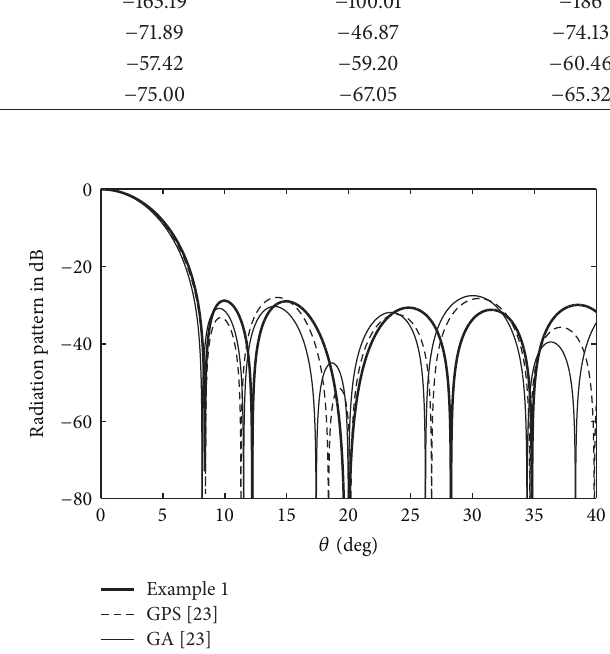
Table 5: Comparison with published results for 2𝑁 = 20 elements optimized with respect to position. SLL FNBW Null depth in dB at 20 ∘ Obtained results − 28.5025